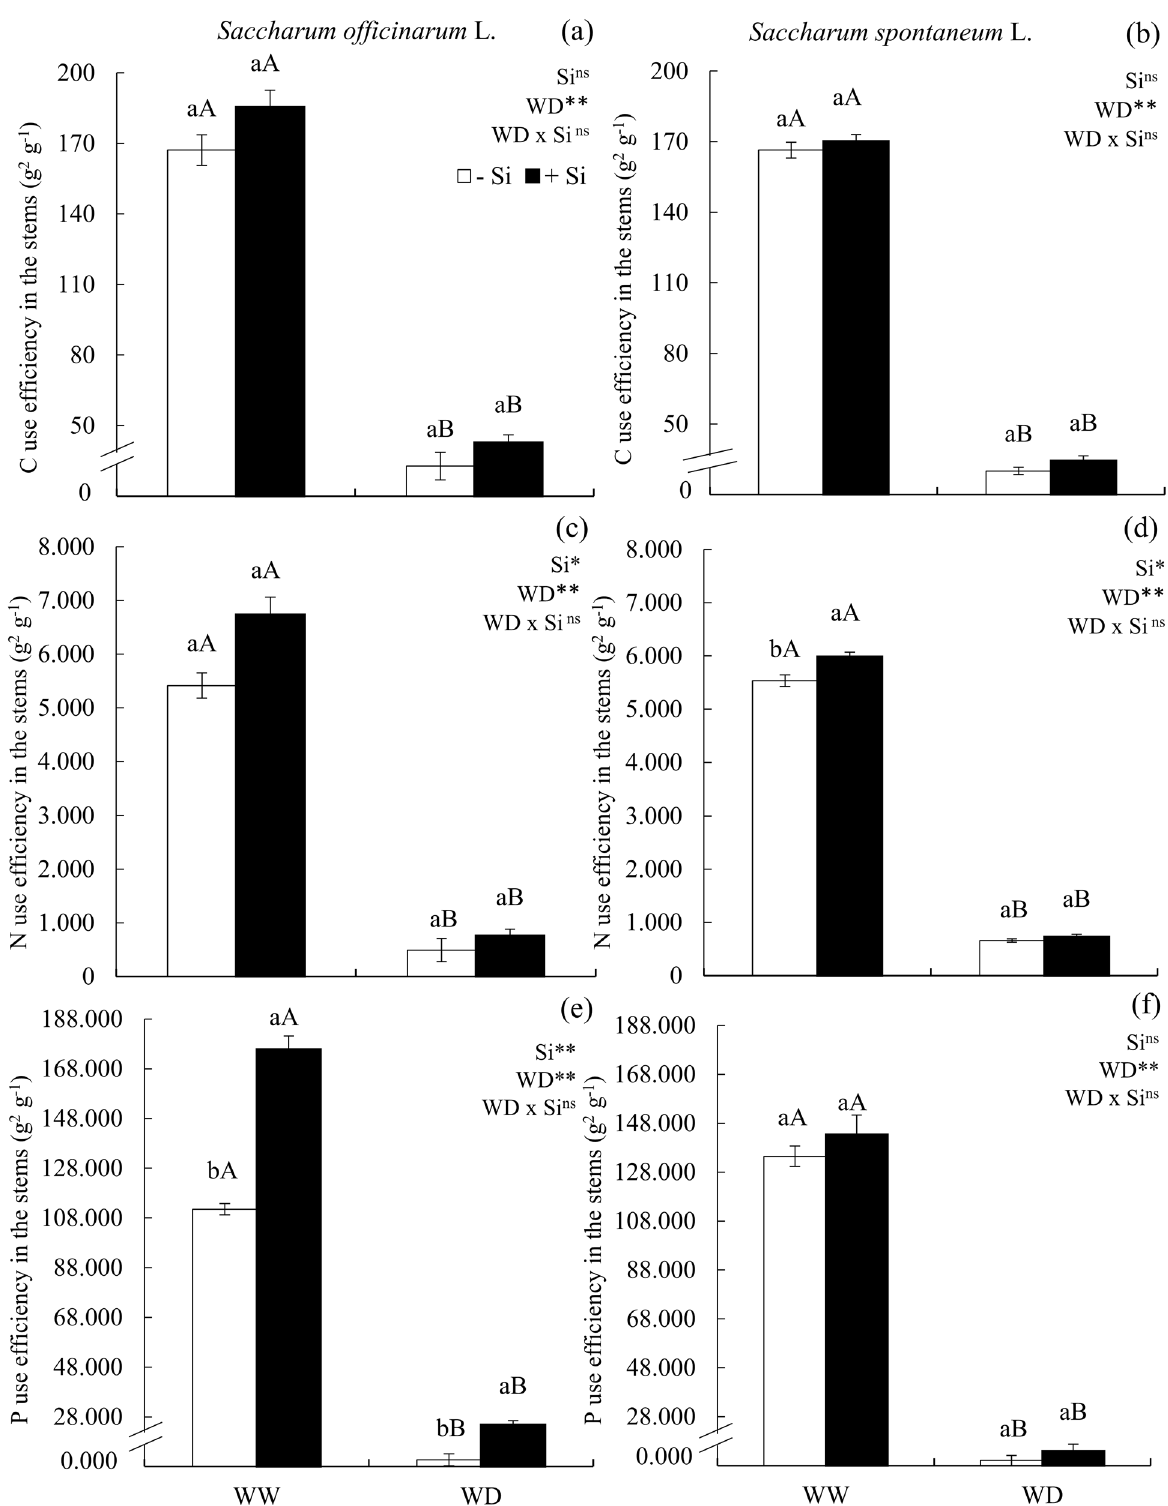
Figure 4. C use efficiency ( a , b ) N use efficiency ( c , d ) P use efficiency ( e , f ) in the stems of ratoon of sugarcane ( Saccharum officinarum L.) ( a , c , e ) and energy cane ( Saccharum spontaneum L.) ( b , d , f ) cultivated without